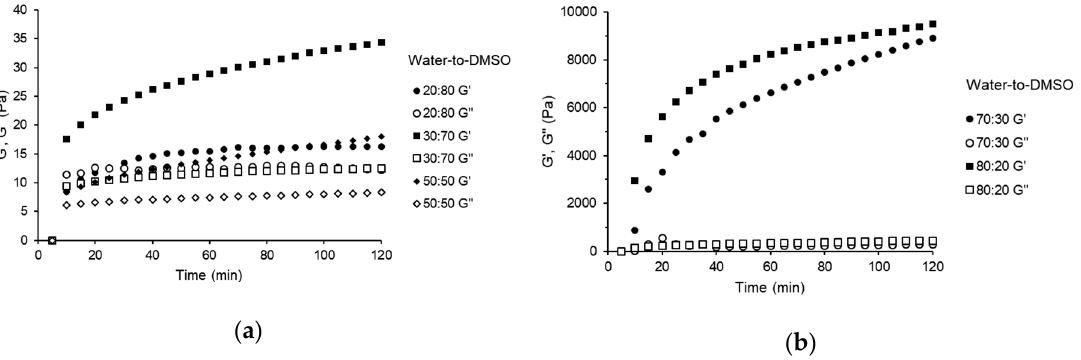
Figure 4. Mechanical spectra of the samples containing 10 wt% starch and different water-to-DMSO mass ratios: ( a ) 20:80, 30:70, and 50:50; ( b ) 70:30 and 80:20.